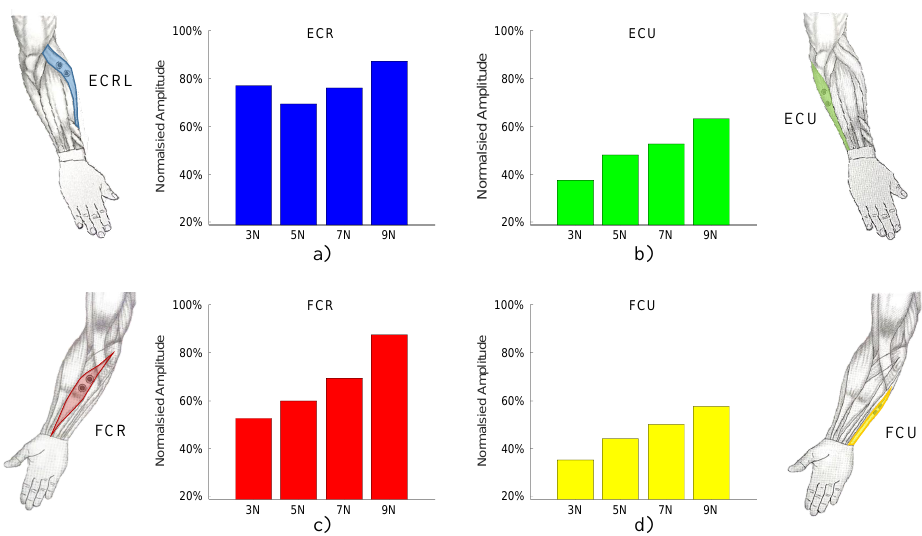
Figure 10. Muscular effort increases with the applied force for the ( a ) ECRL: Extensor Carpi Radials Longus, ( b ) ECU: Extensor Carpi Ulnaris, ( c ) FCR: Flexor Carpi Radialis, ( d ) FCU: Flexor Carpi Ulnaris. Values are shown as percentage of the maximum voluntary contraction